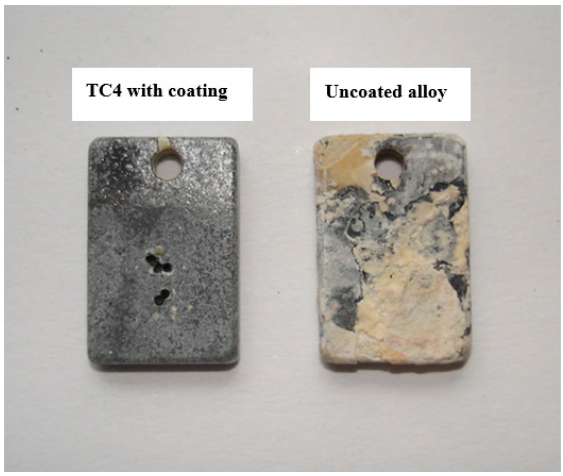
Figure 3. Macrophotograph of TC4 with and without coating after corrosion in marine environment for 100 h at 650 °C.